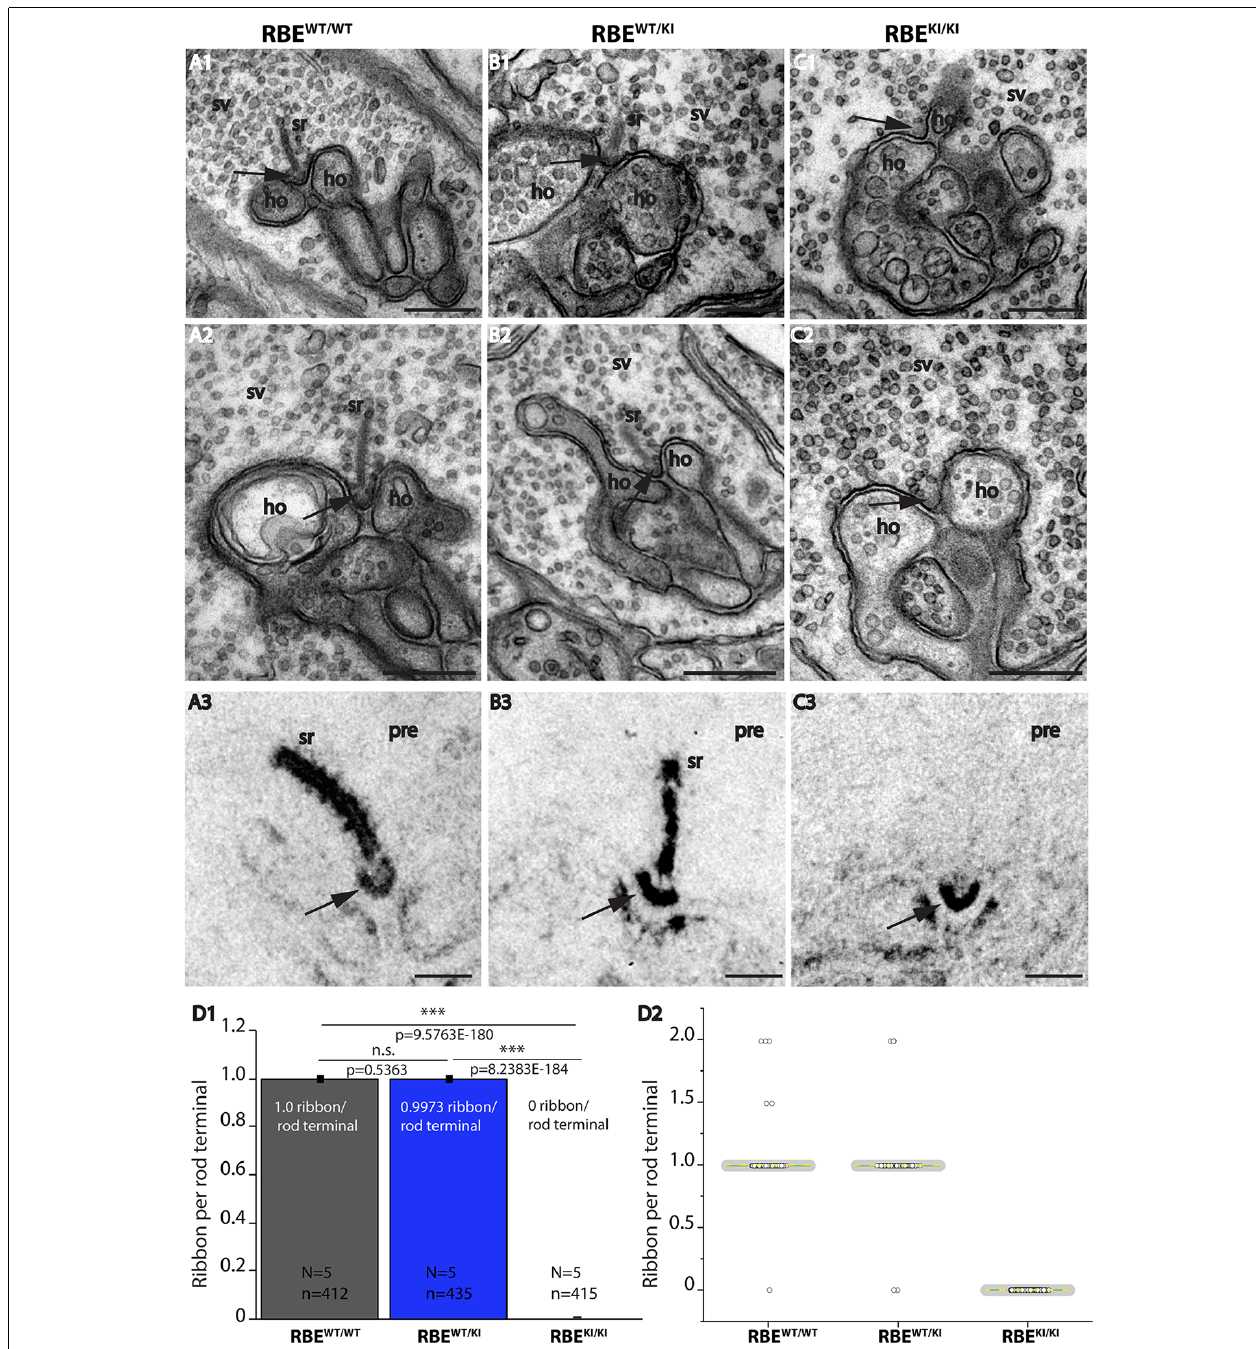
FIGURE 7 | Absence of synaptic ribbons at the active zone of rod photoreceptor terminal from RBE KI/KI mice as demonstrated by transmission electron microscopy. (A–C) Representative transmission EM (TEM) images of rod photoreceptor terminal RBE WT/WT , RBE WT/KI , and RBE KI/KI mice. Panels (A1,A2,B1,B2,C1,C2) show conventional TEM images; panels (A3,B3,C3) show TEM images of E-PTA-stained samples. Arrows indicate the active zone of rod synapses. (C1,C2,C3) Synaptic ribbons are present at the active zone of RBE WT/WT and RBE WT/KI mice, but completely absent from the active zone of RBE KI/KI mice. Except for the absence of synaptic ribbons, the ultrastructure of the rod photoreceptor synapses of RBE KI/KI mice is comparable with control. (D) Quantification of the number of ribbons per rod terminal. Values in (D1) are means ± S.E.M. (n.s., p > 0.05; ∗∗∗ p ≤ 0.001). In the box and whisker plots (D2) of the data from (D1) , mean values are labeled by horizontal yellow dotted line and median values by horizontal green solid line. The box represents 25th-75th percentile, and whiskers represent 1.5 times of interquartile range. Statistical significance analyses were performed by Mann-Whitney U -tests and Kolmogorov-Smirnov tests. Abbreviations: sr, synaptic ribbon; ho, horizontal cells; SV, synaptic vesicles; pre, presynaptic; RBE, RIBEYE; S.E.M., standard error of the mean; N = number of mice, n = number of analyzed images; n.s., non-significant. Scale bar: 200 nm.